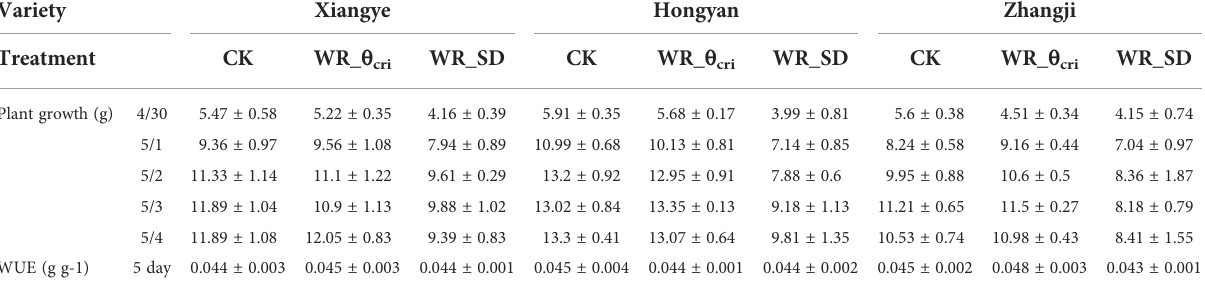
TABLE 1 Daily Plant growth and WUE during the period after water recovery. Variety